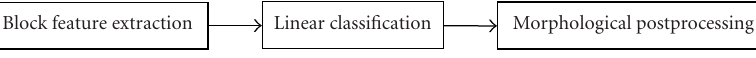
Figure 1: Framework of the segmentation algorithm.